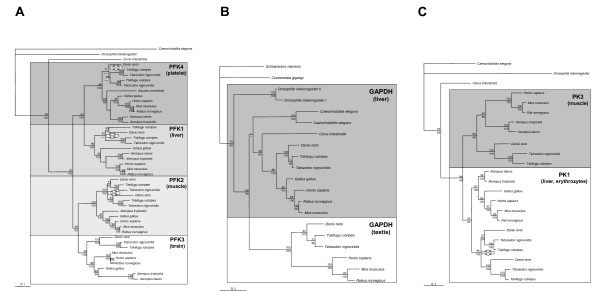
Maximum-likelihood tree of the tetrameric glycolytic enzymes phosphofructokinase (PFK), glyceraldehydes-3-phosphate dehydrogenase (GAPDH) and pyruvate kinase (PK) dataset comprising 44 amino-acid sequences for PFK (430 AA), 22 amino-acid sequences for GAPDH (340 AA), and 23 amino-acid sequences for PK (533 AA). Values at the branches are support values (ML bootstrapping/MB posterior probabilities). "FSGD" depicts putative fish-specific gene duplication events.